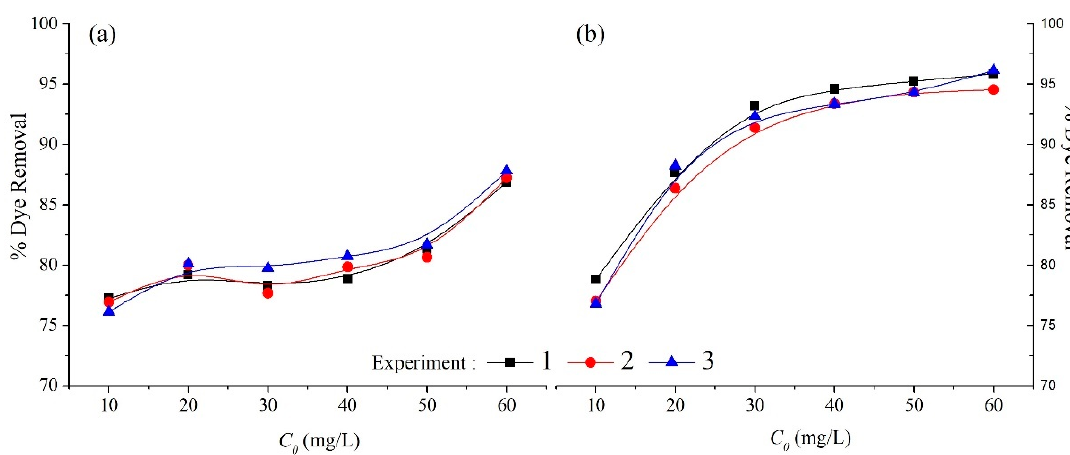
Figure 6. ( a ) Effect of initial Basic Navy Blue 2RN (CNB) dye concentration on dye removal. ( b ) Effect of the initial Drimaren Yellow Cl-2R (ADY) dye concentration on dye removal. Adsorbent dose 0.5 g/50 mL. pH (cationic) = 6, pH (anionic) = 2.